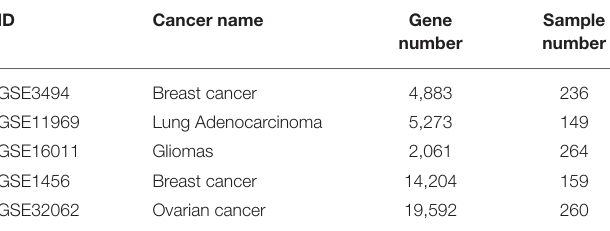
TABLE 2 | Independent test datasets used for confirming predicted biomarkers and for comparison.